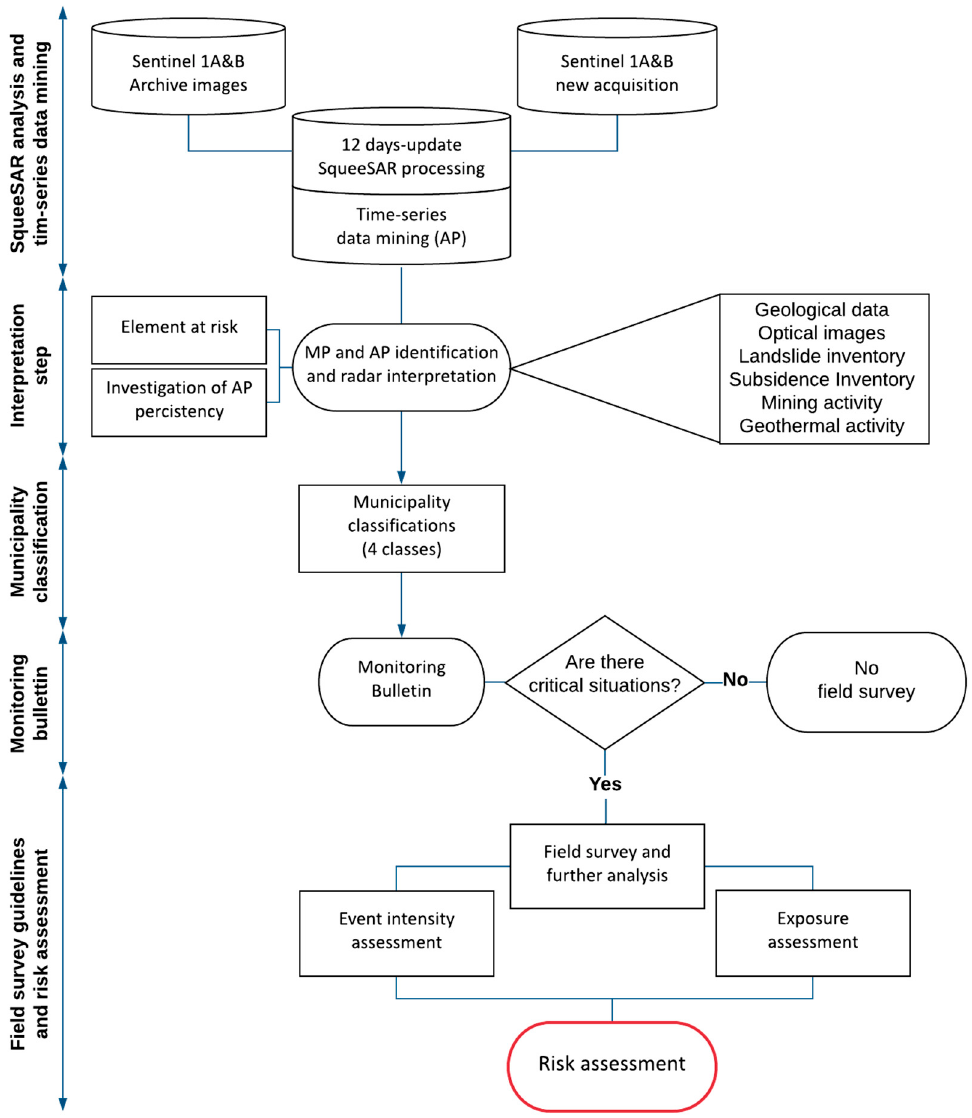
Figure 2. Work flow approach for managing systematic updated Sentinel-1 InSAR data at regional scale.